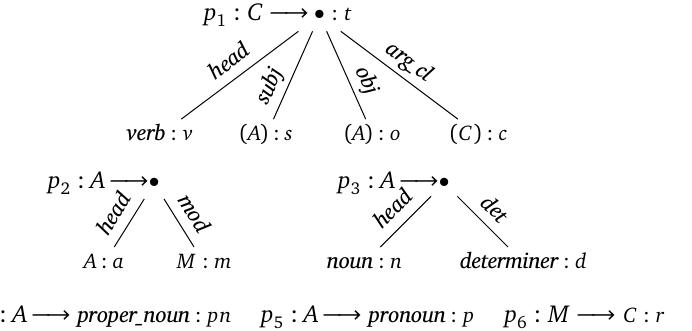
Figure 7: Regular over- approximation of valid